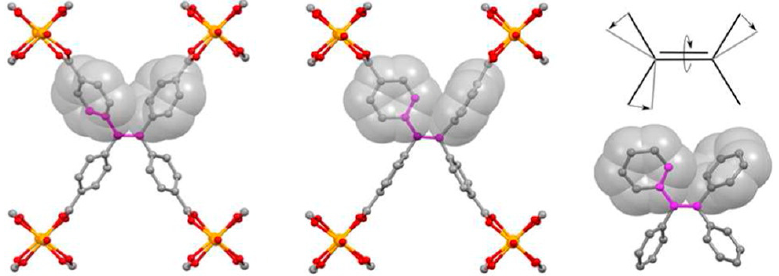
Figure 5. Linker conformation in tetra(4-carboxy)phenylethylene-based MOF, depicting steric hindrance from neighboring rings (left and center). The comparative case of a free tetraphenylethylene molecule is shown on the right. Reproduced with permission from [25]. Copyright American Chemical Society, 2012.